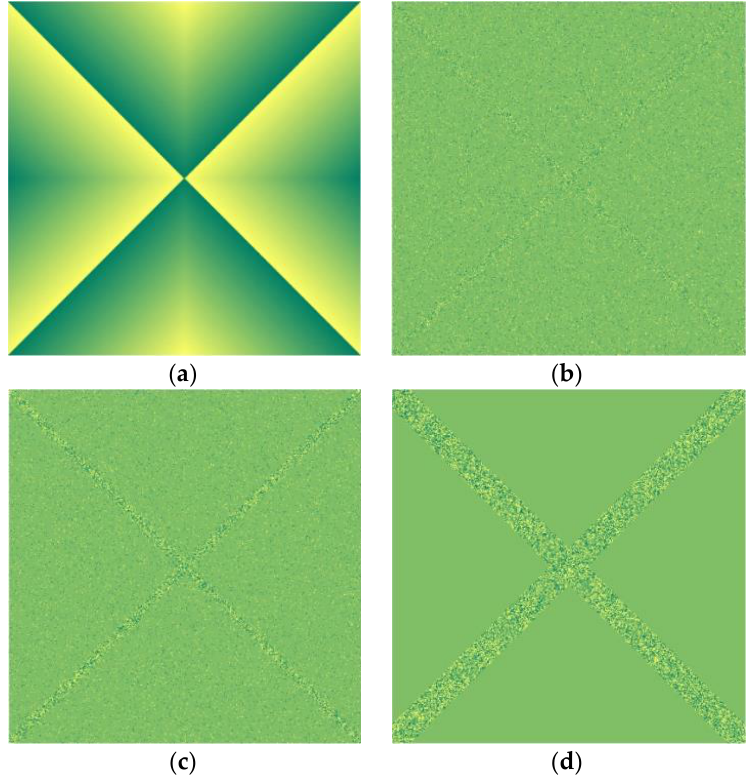
Figure 2. Computer-generated cover image and difference arrays of the cover and stego-image. ( a ) Cover image. ( b ) DI of cover and HILL stego-image. ( c ) DI of S-UNIWARD stego-image. ( d ) DI of WOW stego-image.